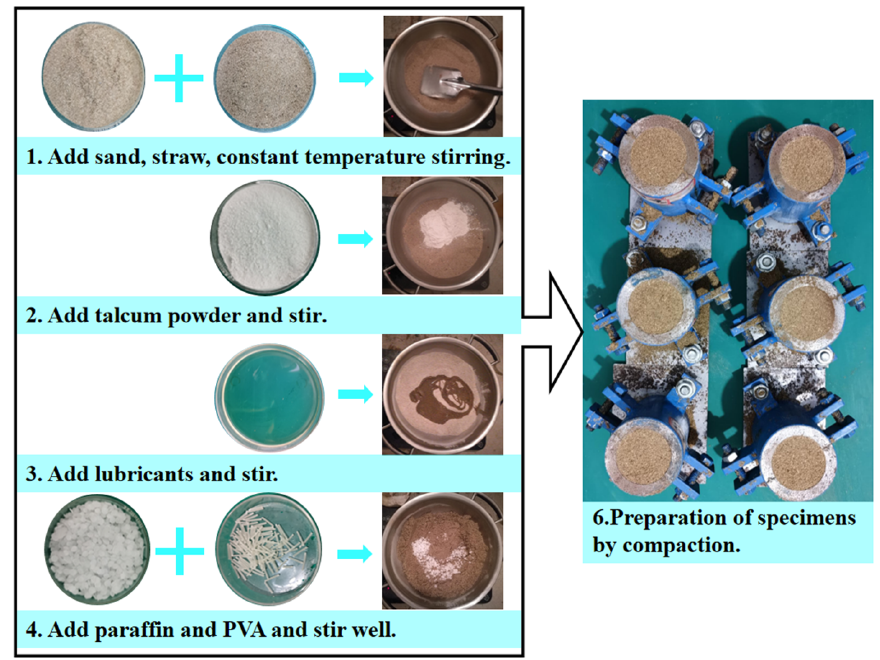
Figure 1. Preparation process of similar ‐ simulation materials.